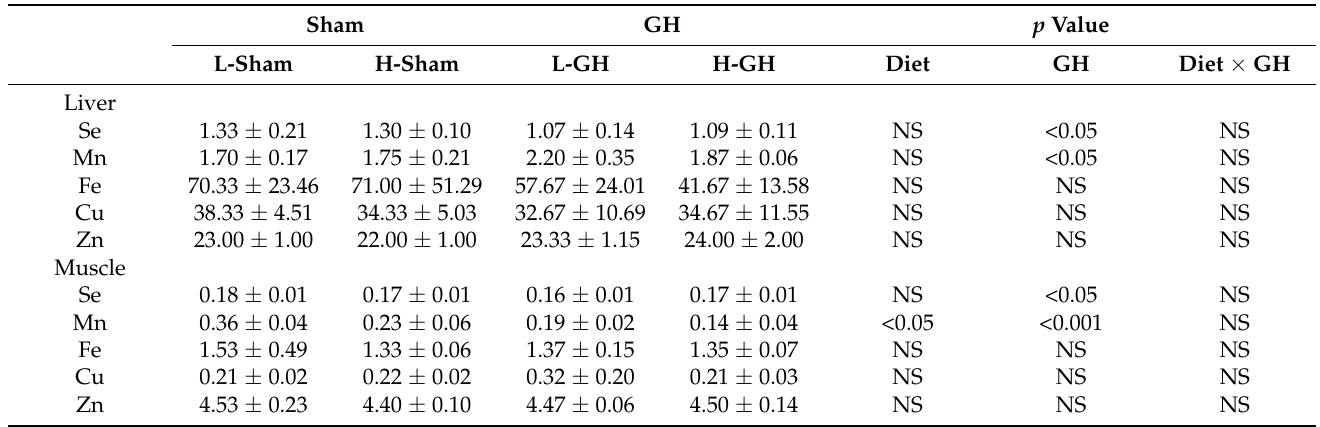
Table 2. Micro-mineral concentration in the liver and muscle of Atlantic salmon during EP2 (mg/kg wet